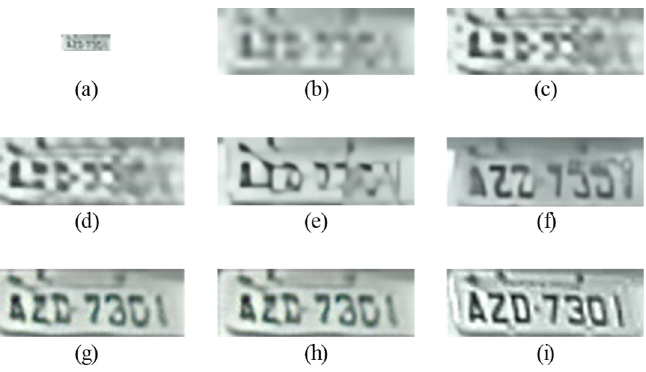
Figure 8. SR results on the LP image of the UFPR dataset for scale factor ( × 3): ( a ) input low-quality legacy image (24 × 8), ( b ) bicubic (96 × 32), ( c ) MZSR, ( d ) DRN, ( e ) SwinIR, ( f ) HIFA-LPR (Step 1), ( g ) HIFA-LPR (Step 2), ( h ) HIFA-LPR (Step 3), ( i ) HR image.